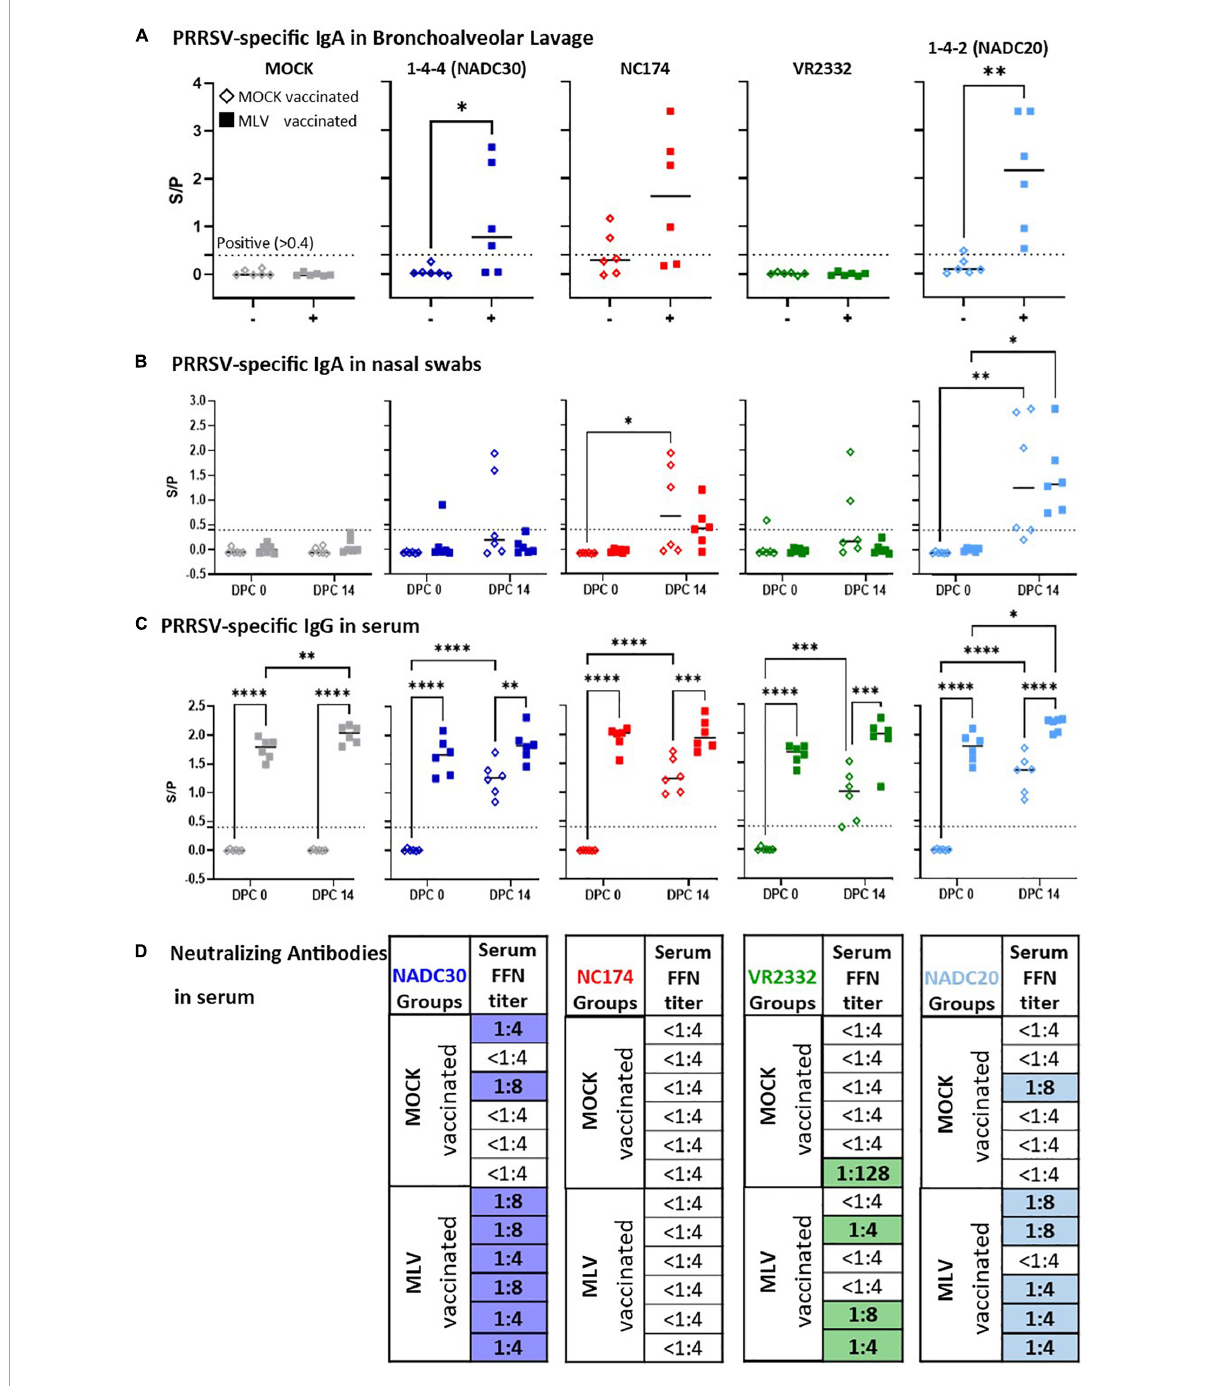
FIGURE4 Heterologous vaccine immunogenicity—the humoral immune response. Immunoglobulin A of (A) bronchoalveolar lavage (BAL), (B) nasal swabs, and (C) serum IgG levels were evaluated at 0 and 14 days post challenge (dpc) via a PRRSV X3 ELISA. The IgA and IgG ELISA S/P ratios were compared within their challenge groups—MOCK (gray), 1-4-4 (NADC30, dark blue), NC174 (red), VR2332 (green), and 1-4-2 (NADC20, light blue). The black bars represent the median values; in addition, individual data points are shown for MOCK vaccinated animals (open diamonds) and MLV vaccinated animals (filled squares). Data were statistically analyzed using a 2-way ANOVA with time and vaccination as the two parameters and Tukey’s multiple comparison test. ∗∗∗∗ p < 0.0001, ∗∗∗ p < 0.001, ∗∗ p < 0.01, ∗ p < 0.05. (D) Neutralizing antibody (NA) titers determined via FFN test against the respective challenge strain at 0 and 14 dpc. Since no animals showed FFN titers at 0 dpc, only the 14 dpc data are shown. Titers ≥ 1:4 were considered positive. The titer for each individual PRRSV-challenged pig is shown. Positive NA titers are highlighted in blue (NADC30), red (NC174, not detected), green (VR2332), and light blue